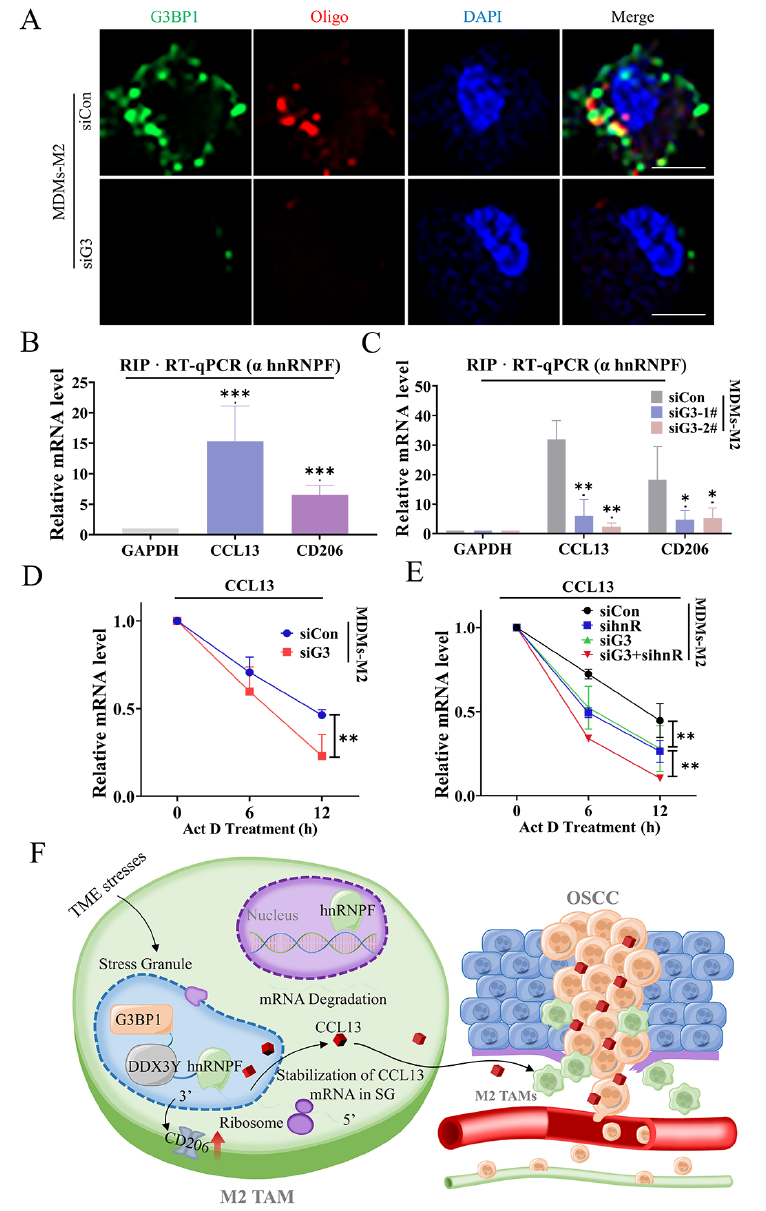
Figure 5. SG formation enhanced DDX3Y/hnRNPF-mediated mRNAs stability via binding with these transcripts. ( A ) Representative images of mRNA FISH detecting CCL13 mRNA and immunofluorescence of G3BP1. Scale bar, 10 μm. ( B ) RIP was performed with MDMs-M2 lysates using antibody against hnRNPF. Bar chart showed RT-qPCR data for the indicated transcripts. ( C ) RIP was performed using lysates from MDMs-M2 transfected with control or G3BP1 siRNA via antibody against hnRNPF. The bar chart showed results of the analysis of the indicated transcripts. ( D ) The degradation of CCL13 mRNA was determined by RT-qPCR after treatment with actinomycin D (5 µ g/mL) for the indicated times in MDMs-M2 following G3BP1 knockdown. ( E ) The assays of CCL13 mRNA stability were performed by RT-qPCR for the indicated times in MDMs-M2 followed by knockdown of G3BP1 and hnRNPF. ( F ) The working model elucidated how M2 TAMs released CCL13 to promote OSCC metastasis. The SG formation enhanced the DDX3Y/hnRNPF-dependent mRNA stability of CCL13 and CD206. TME stressors facilitated SG formation, thus sequestering CCL13 and CD206 mRNA into SG via binding with hnRNPF. The mRNA stability of CCL13 and CD206 were improved in SG. which increased the expression of CD206 and CCL13 in TAMs. Finally, the CCL13 from M2 TAMs promoted OSCC metastasis. (*, p < 0.05; **, p < 0.01 and ***, p <